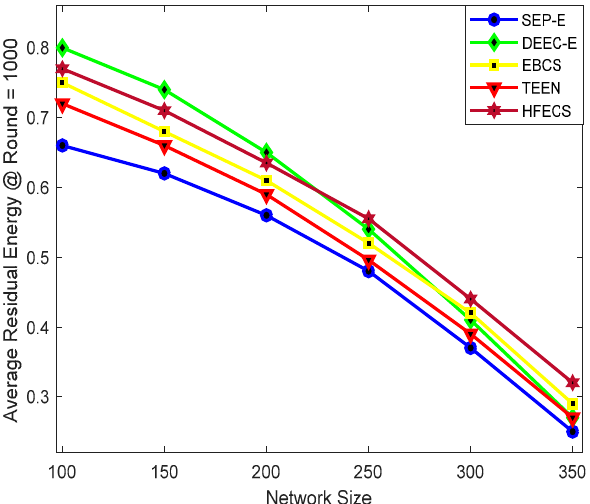
Figure 5. Average residual energy at round=1000 against variable network size.